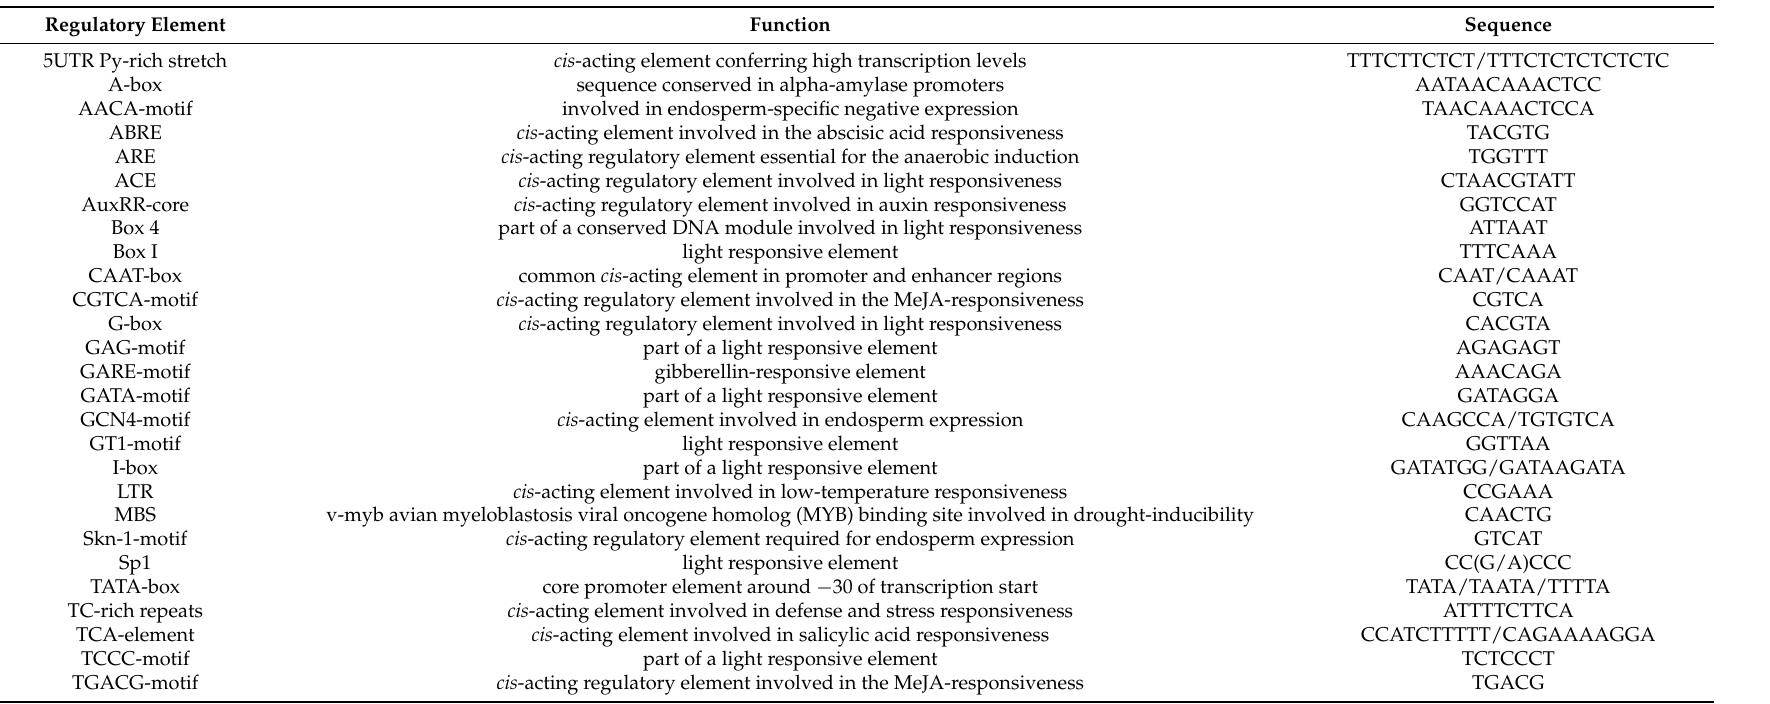
Table 1. Prediction of regulatory elements in the 5 1 -flanking sequence of DlRan3B